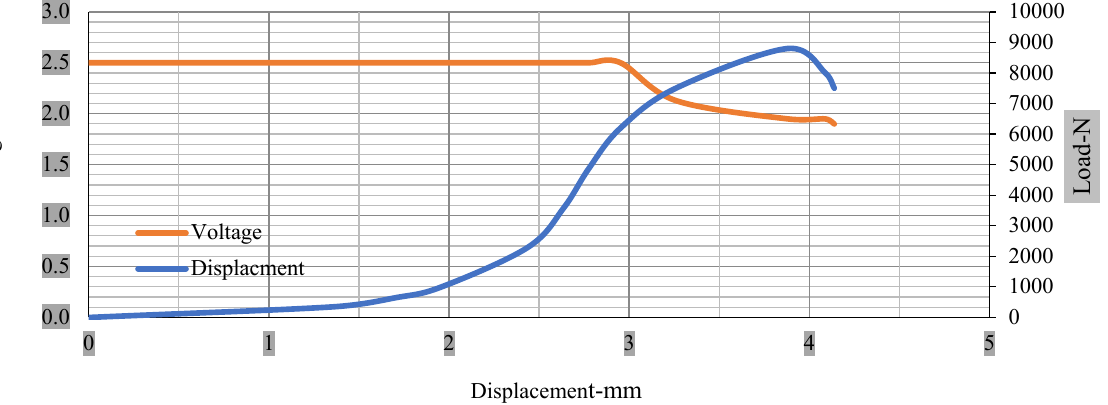
Figure 6. Load and voltage vs. displacement 12 mm punch greater than 10% soc.